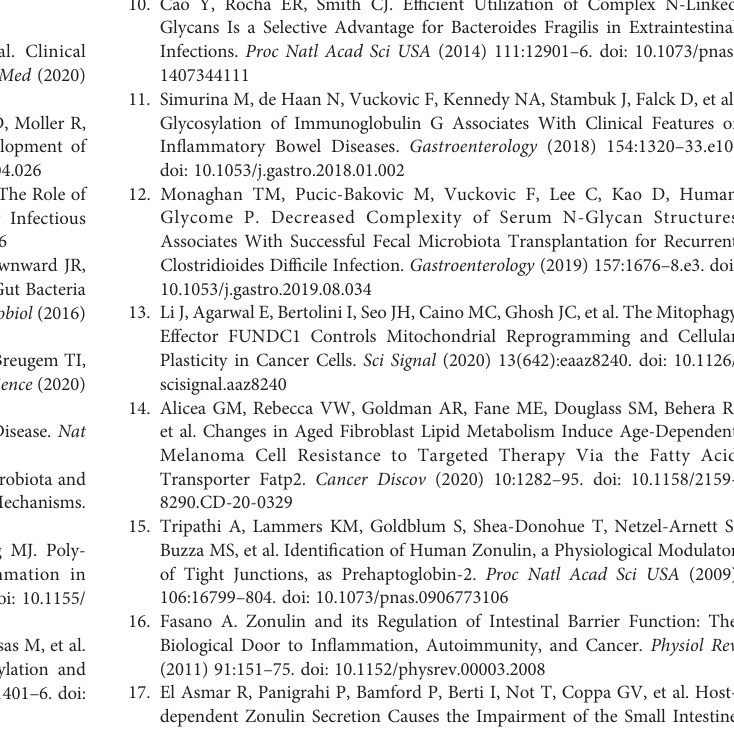
Supplementary Figure 1 | Age was not signi fi cantly different between the groups in the main cohort. Kruskal – Wallis test was used for statistical analysis. Supplementary Figure 2 | Top 50 metabolites dysregulated by COVID-19. Heat-maps depicting the top 25 metabolites induced and the top 25 metabolites reduced by COVID-19 (FDR<0.05). Statistical signi fi cance was determined using theKruskal – Wallistest.FDRwascalculatedusingBenjamini-Hochbergmethod.SC rho = coef fi cient of correlation with COVID-19 severity. Heat colors show standardized Z-scores across samples; red indicates upregulation, and blue indicates downregulation. Supplementary Figure 3 | Levels of key markers are not different between groups with different diabetes or blood pressure status. (A) No = non-diabetic; Pre = Pre- diabetic; and Yes = diabetic. Statistical signi fi cance was determined using the Kruskal – Wallis test (ns = non-signi fi cant; P>0.05). (B) No = not suffering from high blood pressure and Yes = suffering from high blood pressure. Statistical signi fi cance was determined using the Mann – Whitney U test (ns = non-signi fi cant; P>0.05). Supplementary Figure 4 | The COVID-19-associated plasma glycomic signatures are associated with microbial translocation and systemic in fl ammation. Correlation heat-maps depicting the correlations between COVID-19 modulated plasma glycans and (A) markers of tight junction permeability and microbial translocation or (B) markers of in fl ammation and immune dysfunction. SC rho = coef fi cient of correlation with COVID-19 severity. Red-colored correlations = signi fi cant positive correlations with FDR<0.05, blue-colored correlations = signi fi cant negative correlations with FDR<0.05, and gray-colored correlations = non-signi fi cant